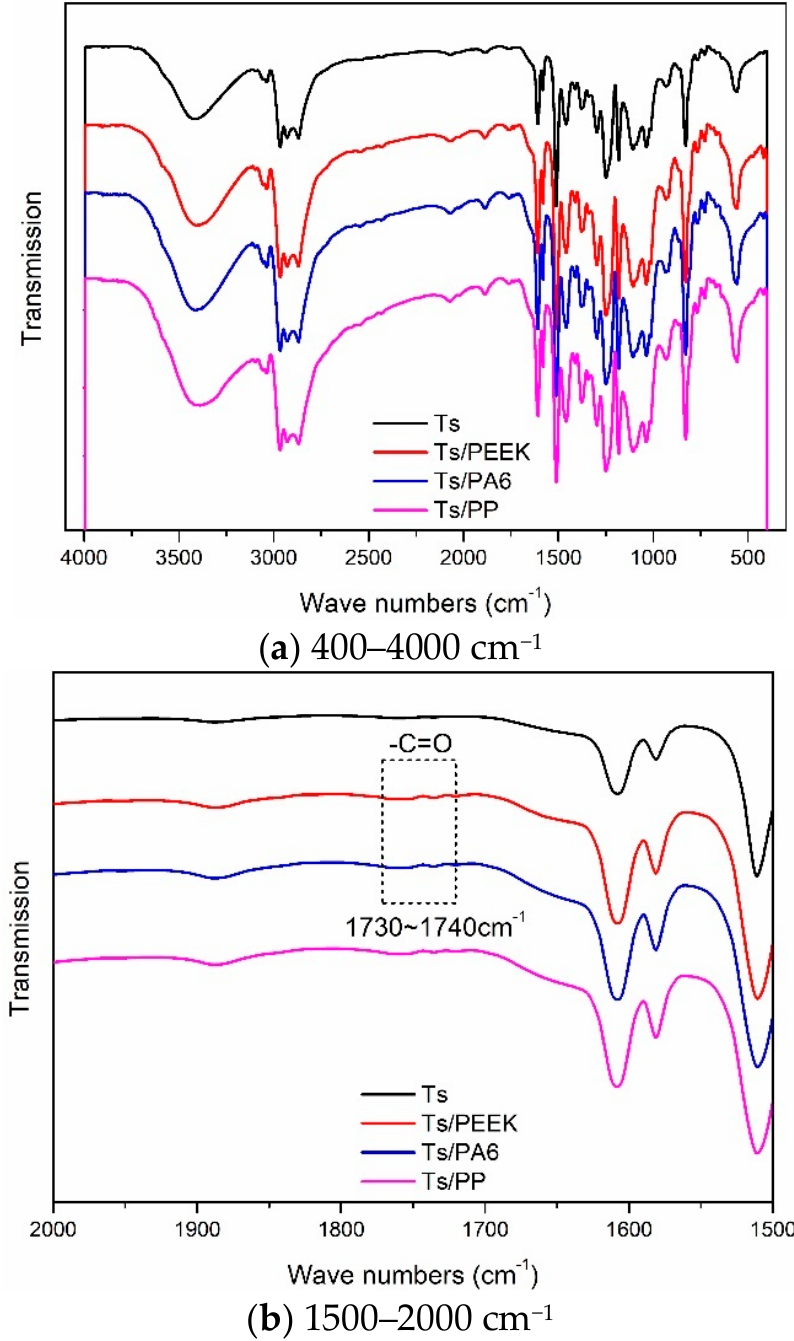
Figure 14. Effects of thermoplastic resin fillers on infrared transmission of Ts resin of ( a ) 400–4000 cm − 1 and ( b ) 1500–2000 cm − 1 .